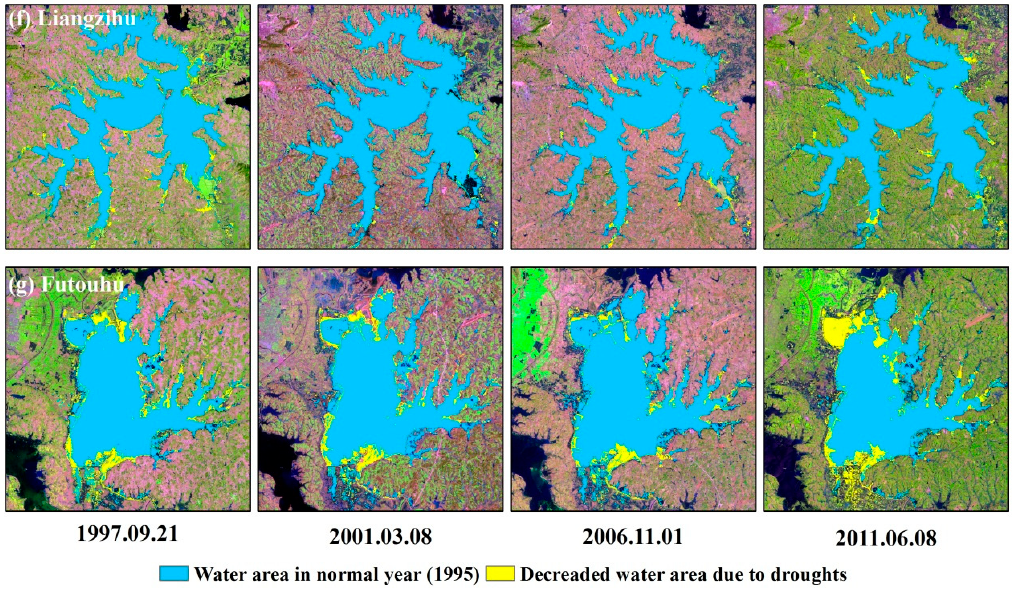
Figure 11. Decreased water area due to droughts in four periods: 1997, 2001, 2006, and 2011. The lake water areas refer to the composited maximum area in the same year.